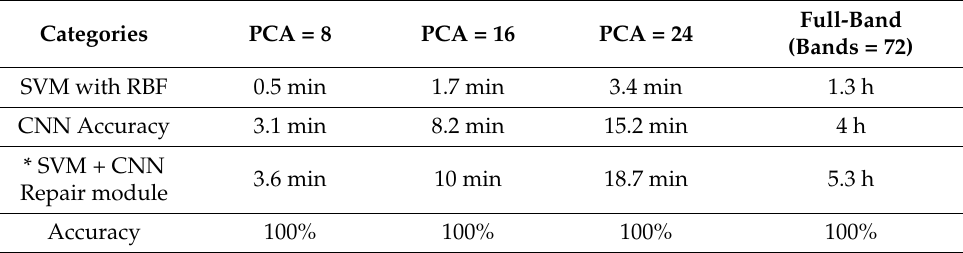
Table 8. The classification outcomes of SVM and SVM +